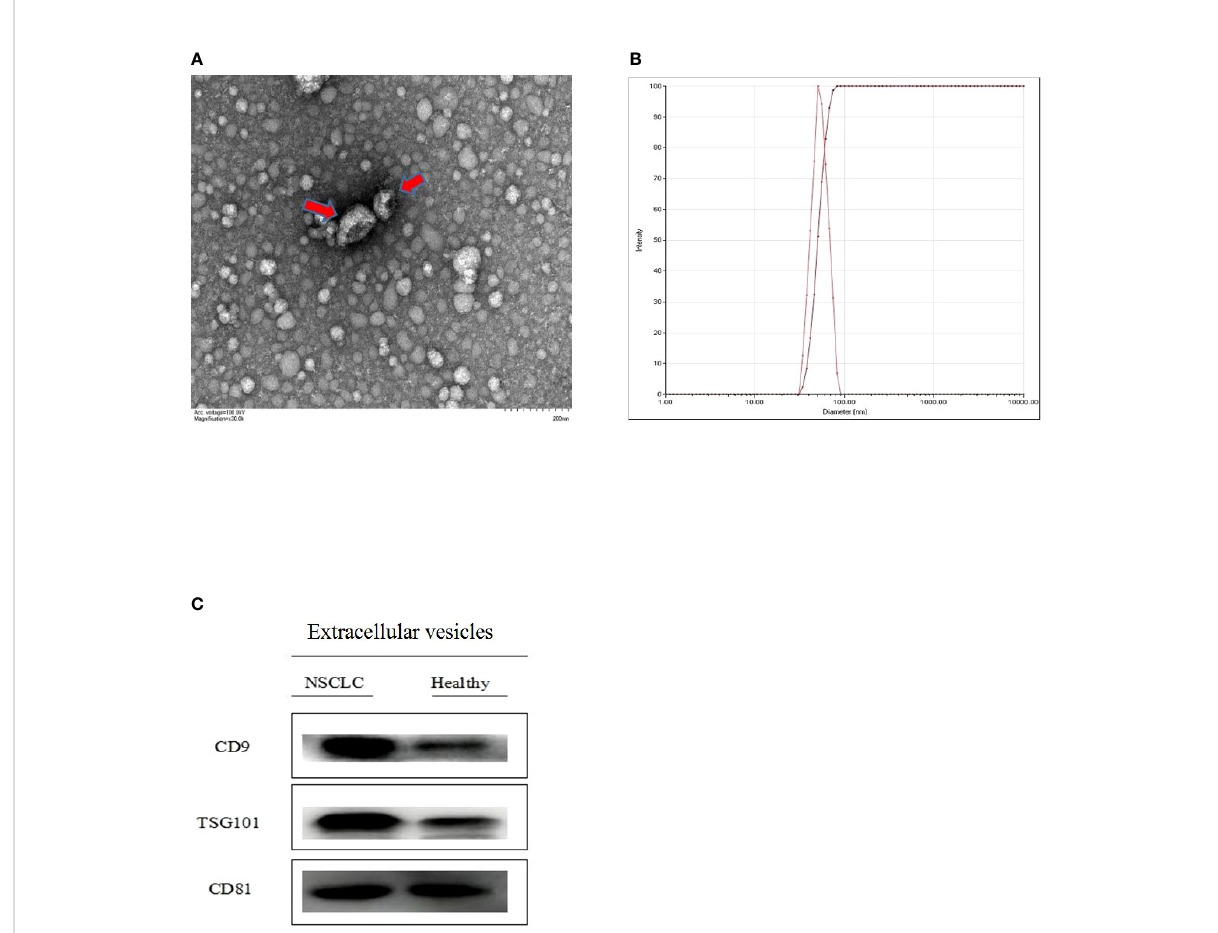
FIGURE 2 Identi fi cation of extracellular vesicles isolated from serum (A) the morphological characteristics of extracellular vesicles was observed by transmission electron microscope (TEM) (B) the diameter distribution and intensity of extracellular vesicles were analyzed through nano particle tracking analysis (NTA) (C) Extracellular vesicles specitic marker proteins (CD9, CD81 and TSG101) were detected by Western